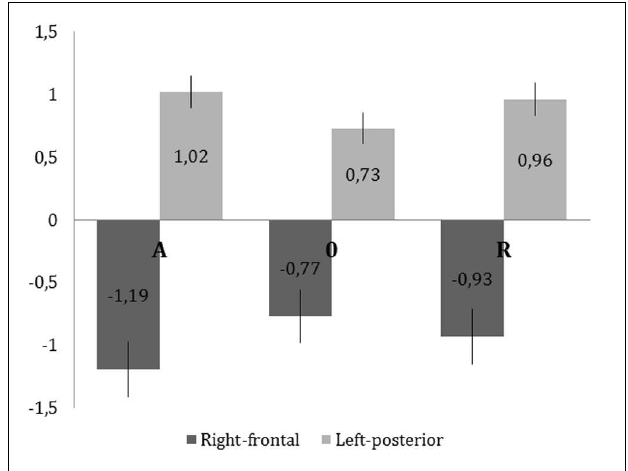
FIGURE 5 | Mean amplitudes for each level of origin in the right frontal (dark) and left posterior (light) ROIs in the 375-670ms time window. The vertical lines represent SEM